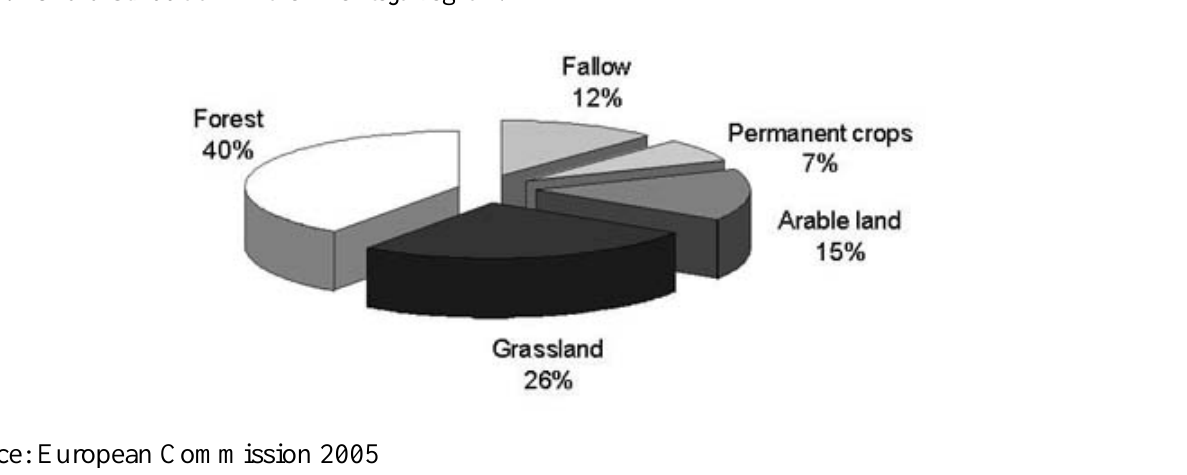
Fig. 4. Land distribution in the Alentejo